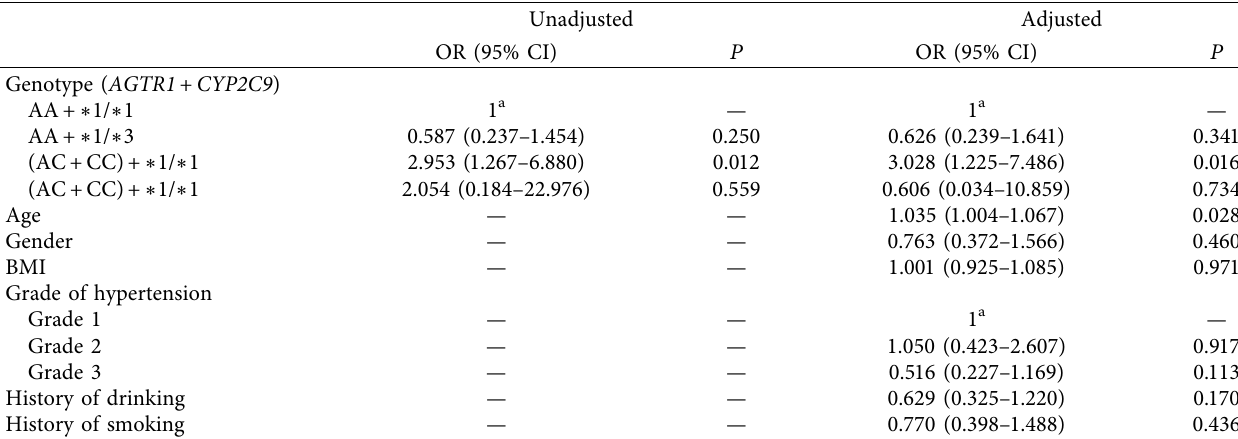
Table 4: Combined effect of AGTR1 A1166C and CYP2C9 ∗ 3 polymorphisms on antihypertensive efficacy of valsartan.